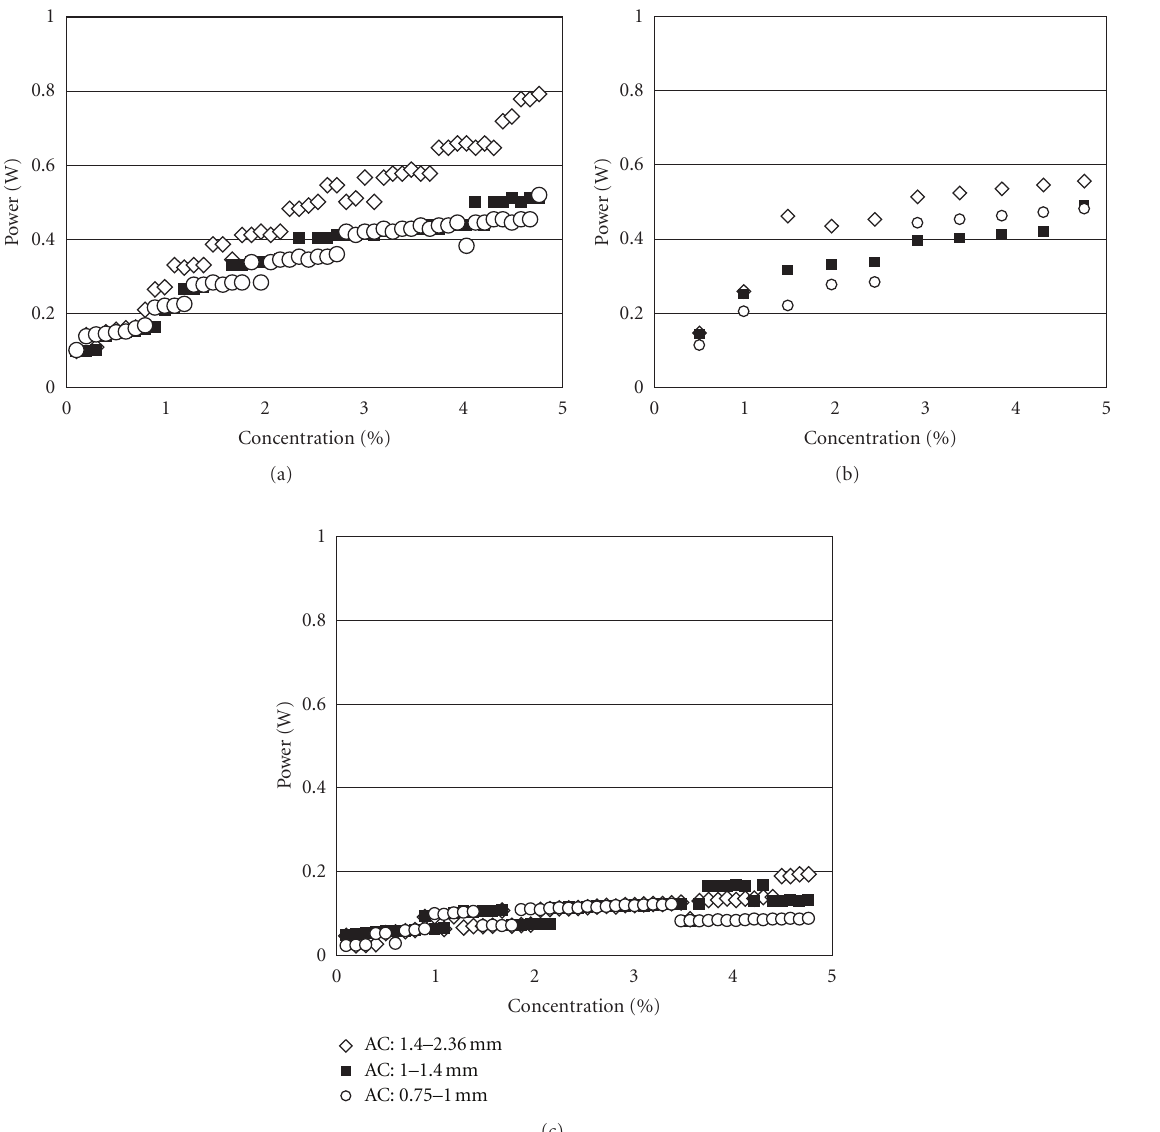
Figure 13: Graph power (watt) versus concentration (%), at varying sizes of activated carbon. (a) 6CB impeller, (b) 6DT impeller, and (c) 6MFD